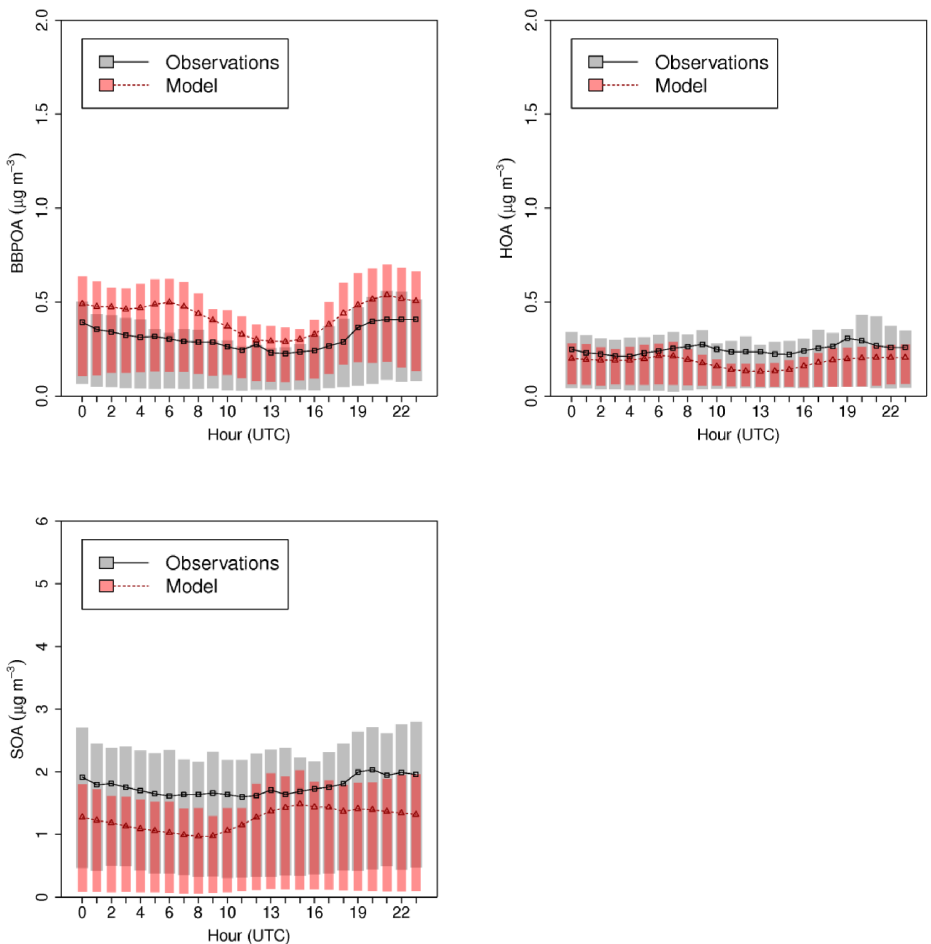
Figure 9. Comparison of modelled (red) and measured (grey) BBPOA, HOA and SOA diurnal profiles at the rural-background sites. The extent of the bars indicates the 25th and 75th